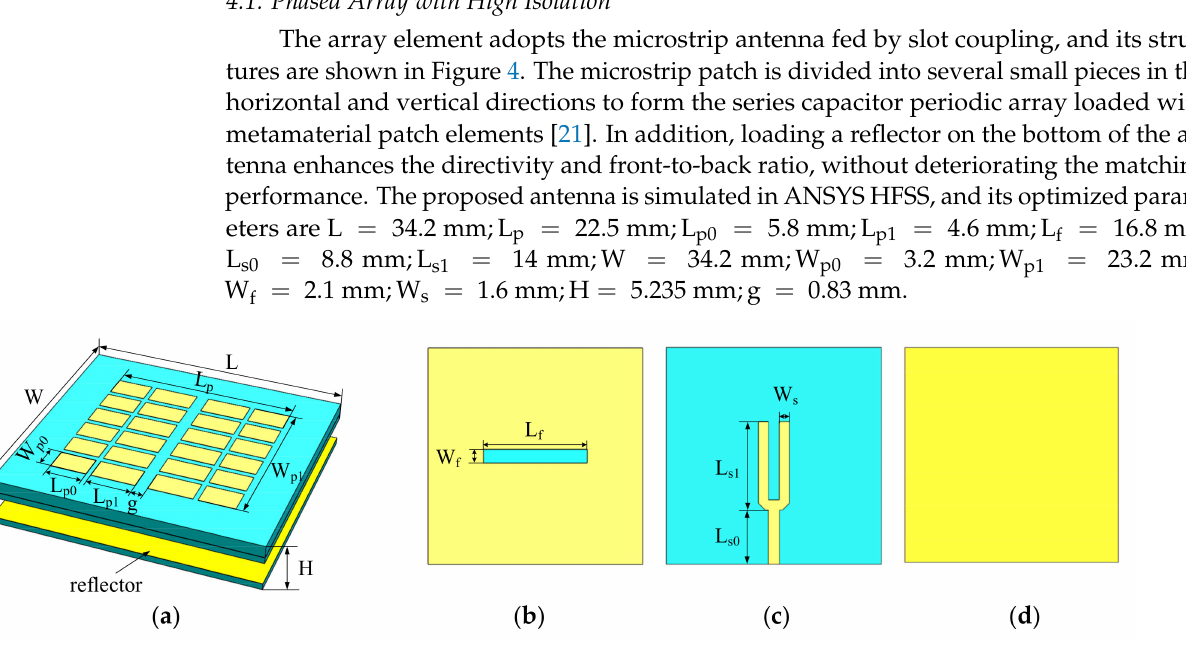
Figure 4. Broadband antenna model: ( a ) 3D view; ( b ) gap structure; ( c ) feed-network; ( d ) metal reflector.